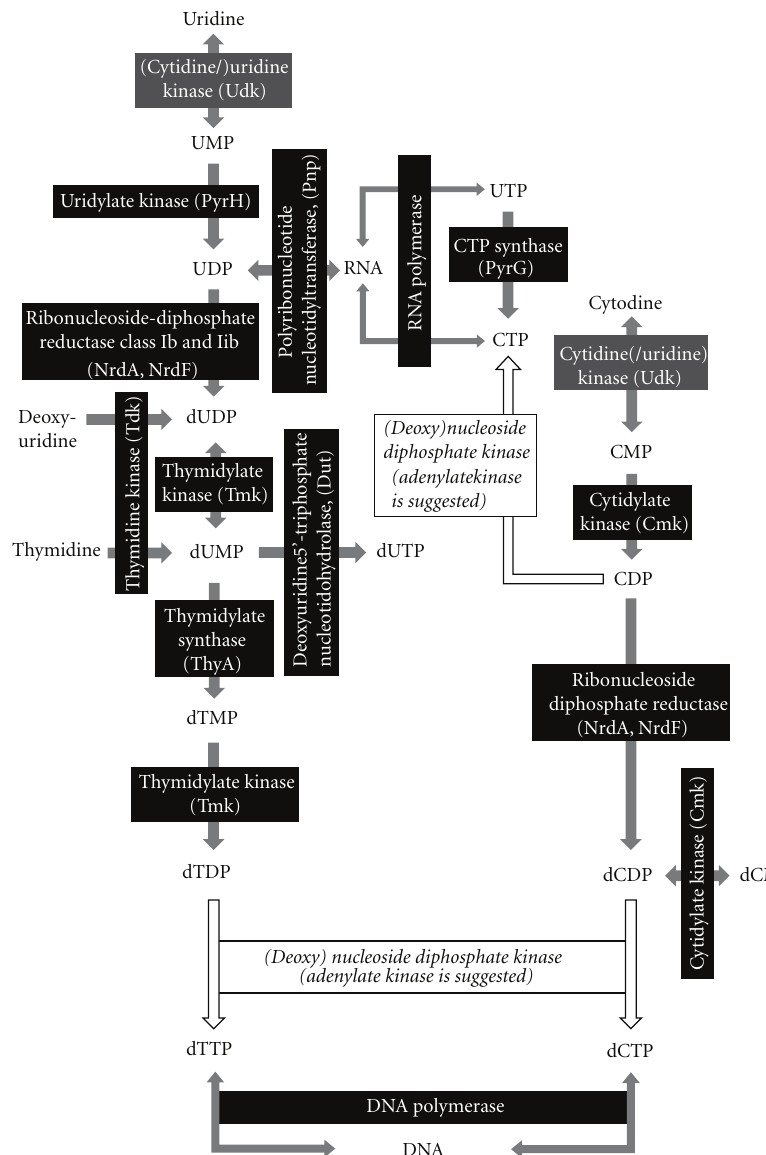
Figure 10: Principle of pyrimidine metabolism in